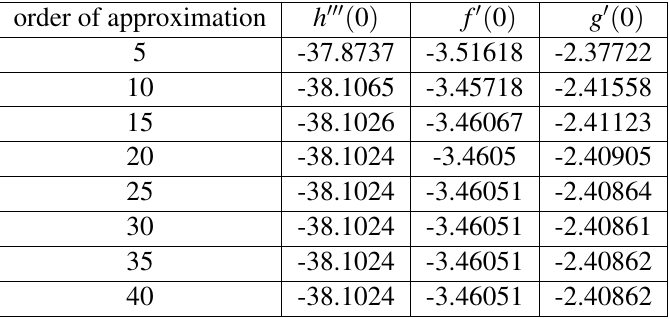
Table 1 Convergence of HAM solutions for different order of approximations for R = 10 when ¯ h h = ¯ h f = ¯ h g = − 1.